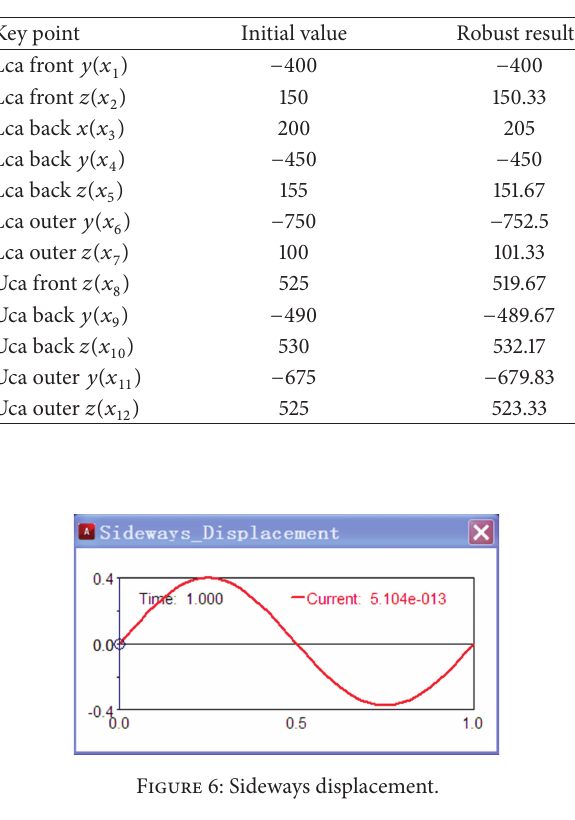
Table 4: Robust results.